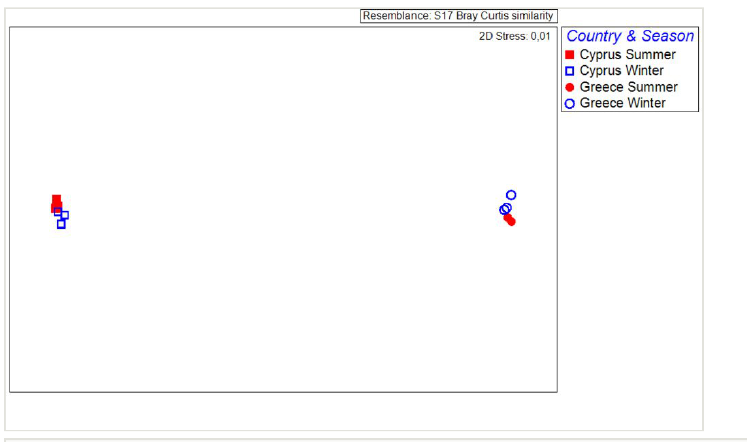
Multidimensional scaling of the sponge samples, based on the individual count of the associated species per sponge volume. Data labels according to the location of the sampling station and the sampling